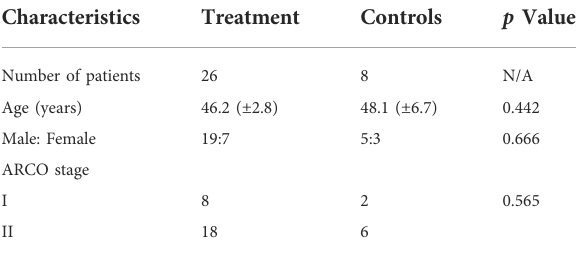
TABLE 1 Information of included